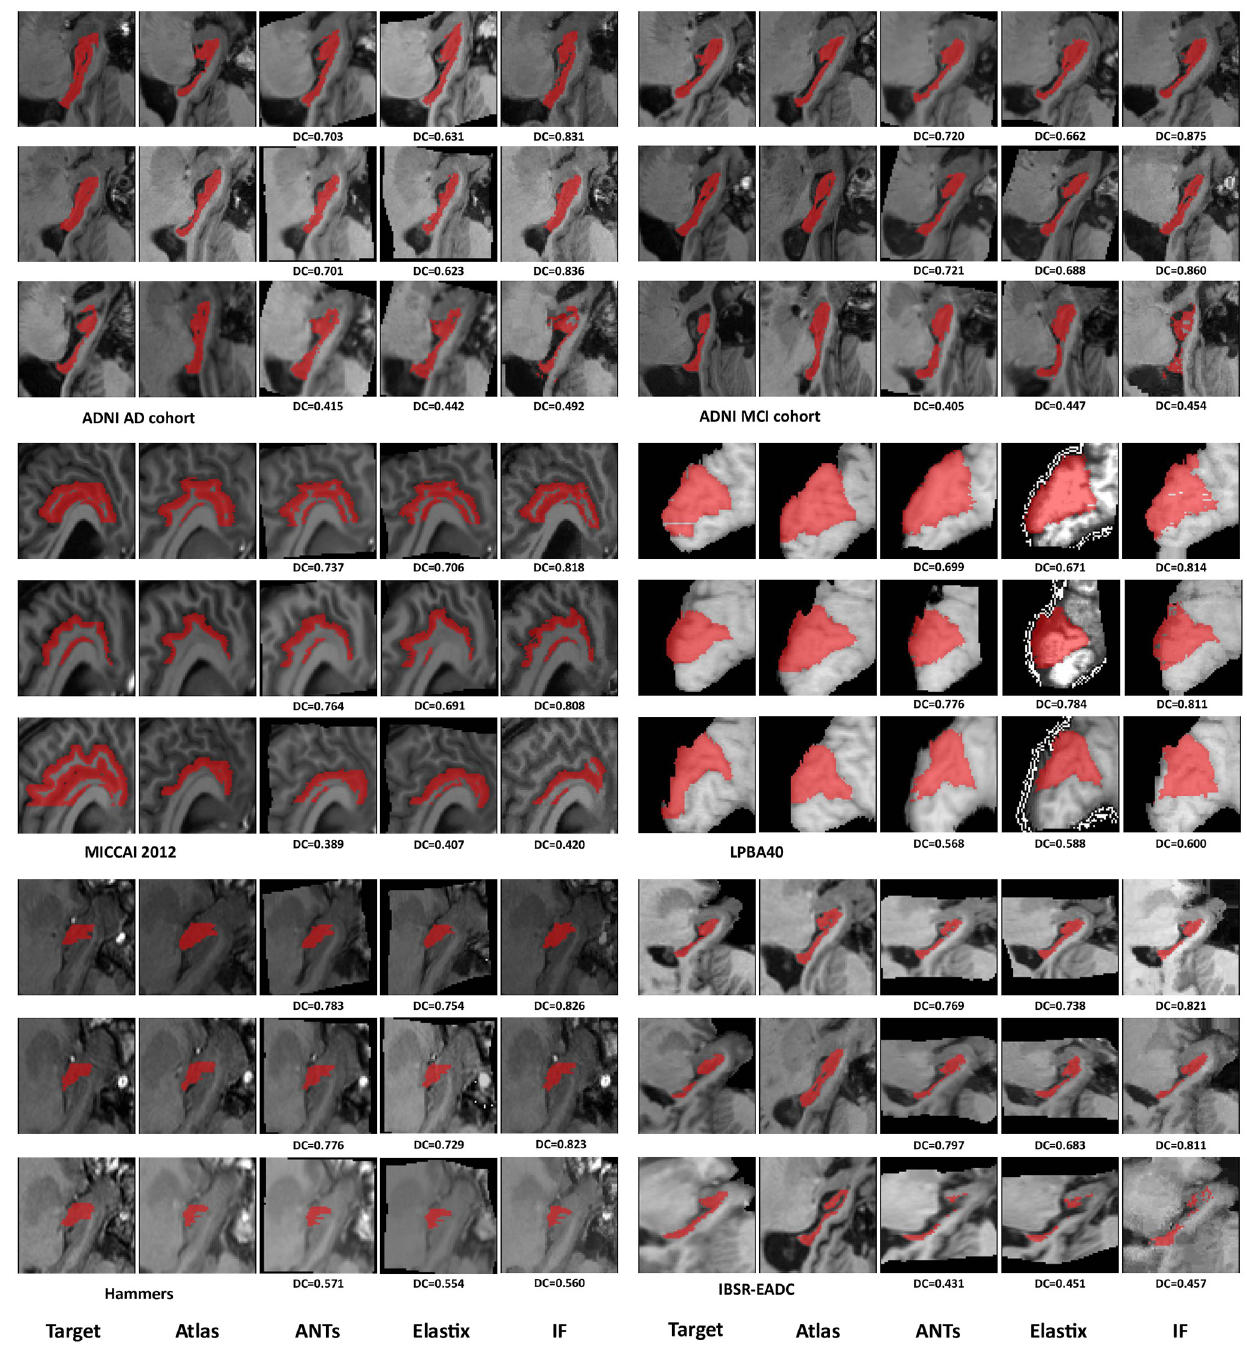
Fig 7. Graphical comparisons of three registration methods. Three examples from each dataset or cohort are illustrated. The shown images are the ground truth, the moving image, the registration result of ANTs, Elastix and our method, from left to right. Sagittal slices are adopted for the LPBA40 dataset while coronal slices are used for other datasets. ANTs: ANTs SyN. IF: the integrated flow (our method). DC: the Dice coefficient.